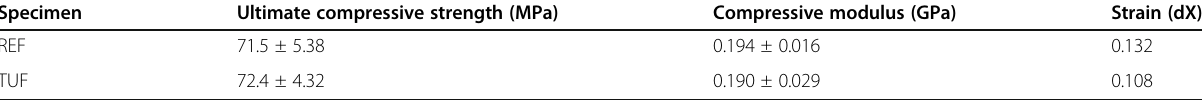
Table 2 Ultimate compressive strength and compressive modulus of REF and TUF green biocomposite